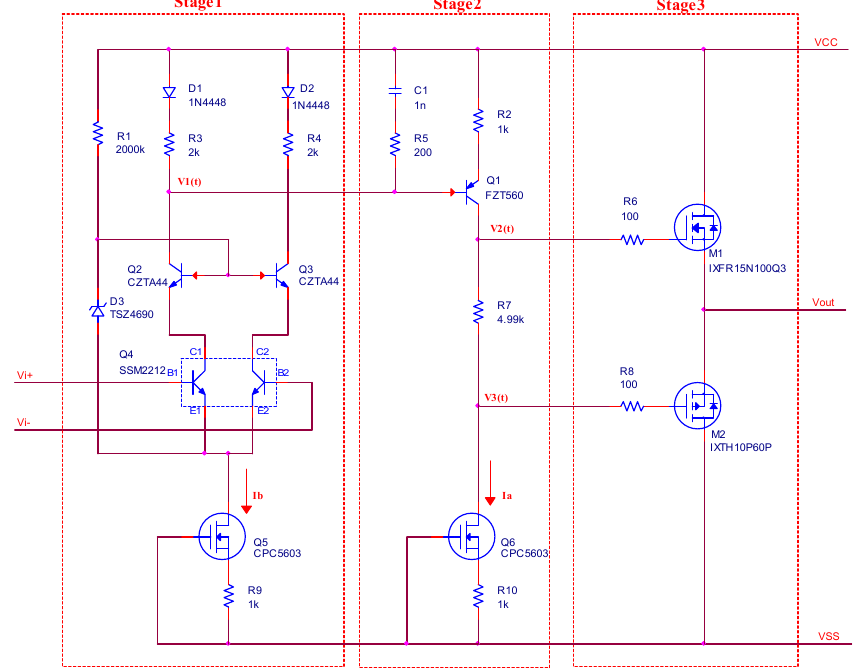
Figure 1. The schematic of the high-voltage operational amplifier.